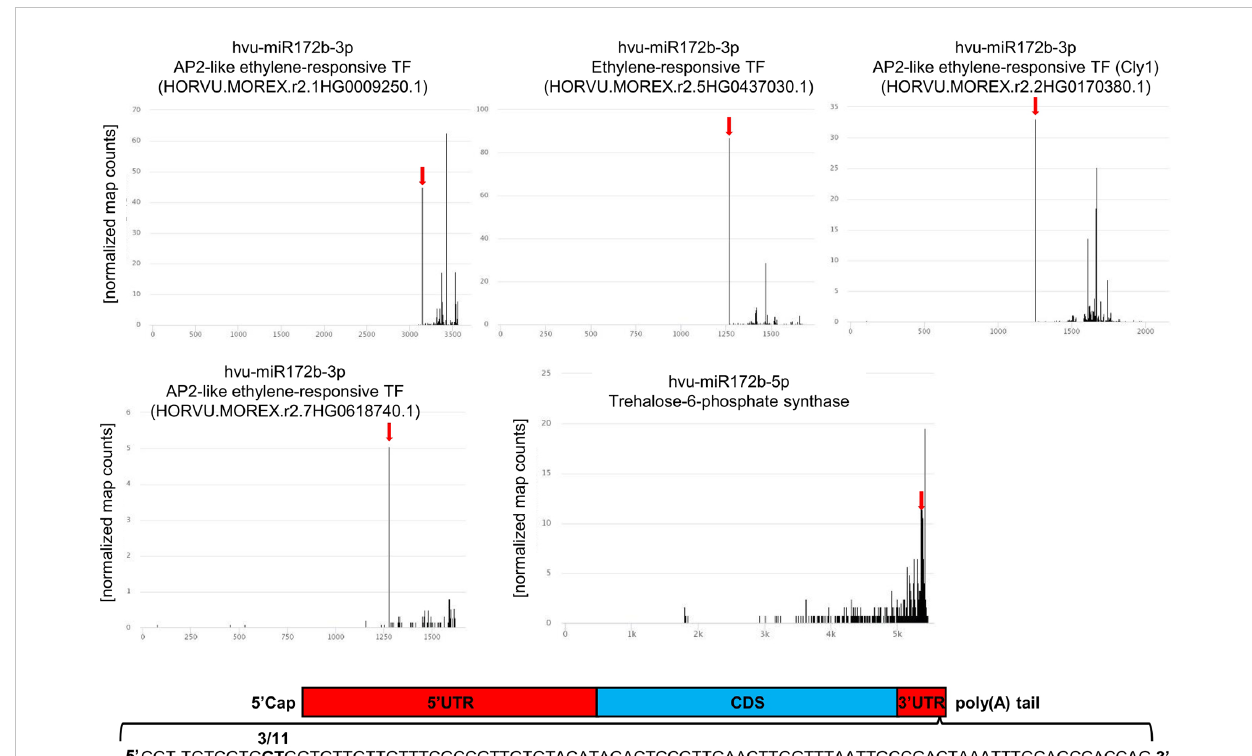
FIGURE 5 Targets of hvu-miR172b-3p and hvu-miR172b-5p. Four barley AP2-like targets are cleaved by hvu-miR172b-3p. The target of hvu-miR172b-5p is trehalose-6-phosphate synthase mRNA. The red arrow indicates the predicted hvu-miR172b-3p or hvu-miR172b-5p cleavage site in four AP2-like or trehalose-6-phosphate synthase ( TPS ) mRNAs. The predicted cleavage sites are consistent with the parallel analysis of RNA ends depicted as target plots (t-plots). The names of the microRNA and targeted mRNA are given above each graph; in the case of the AP2-like gene numbers, they are given in brackets. The x-axis on the t-plots represents the nucleotide length of the targeted mRNAs; the y-axis shows the normalized number of reads. In the case of TPS mRNA, the cleavage site was validated with the 5 ’ RACE method; the numbers of clones represent the ratio of positive to all analyzed clones. Two bolded nucleotides within mRNA depict the cleavage site. The sequence represents miRNA:mRNA hybridization and the end of 3 ’ UTR